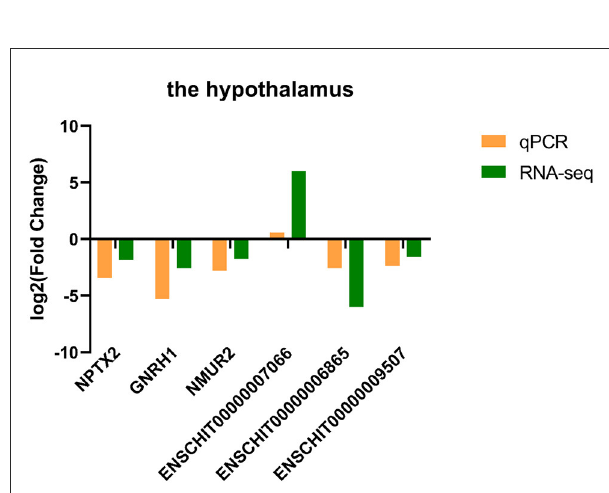
FIGURE5 The qPCR validation results of DE lncRNAs and DE mRNAs for the